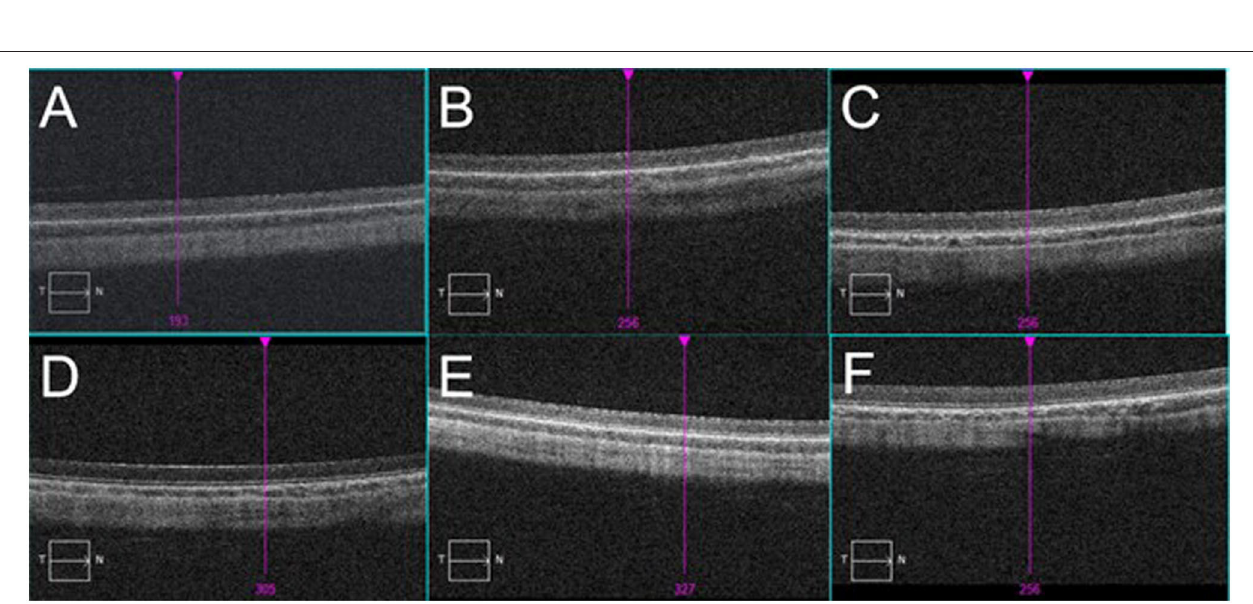
FIGURE 7 | Typical images of OCT scan on the eyes of rabbits. (A) : Blank control group: retina was well-attached, and layers of retina were in order. (B–F) : Eyes exposed to 500, 1,000, 1,500, 2,000, and 5,000 Kpa: No abnormality was observed.